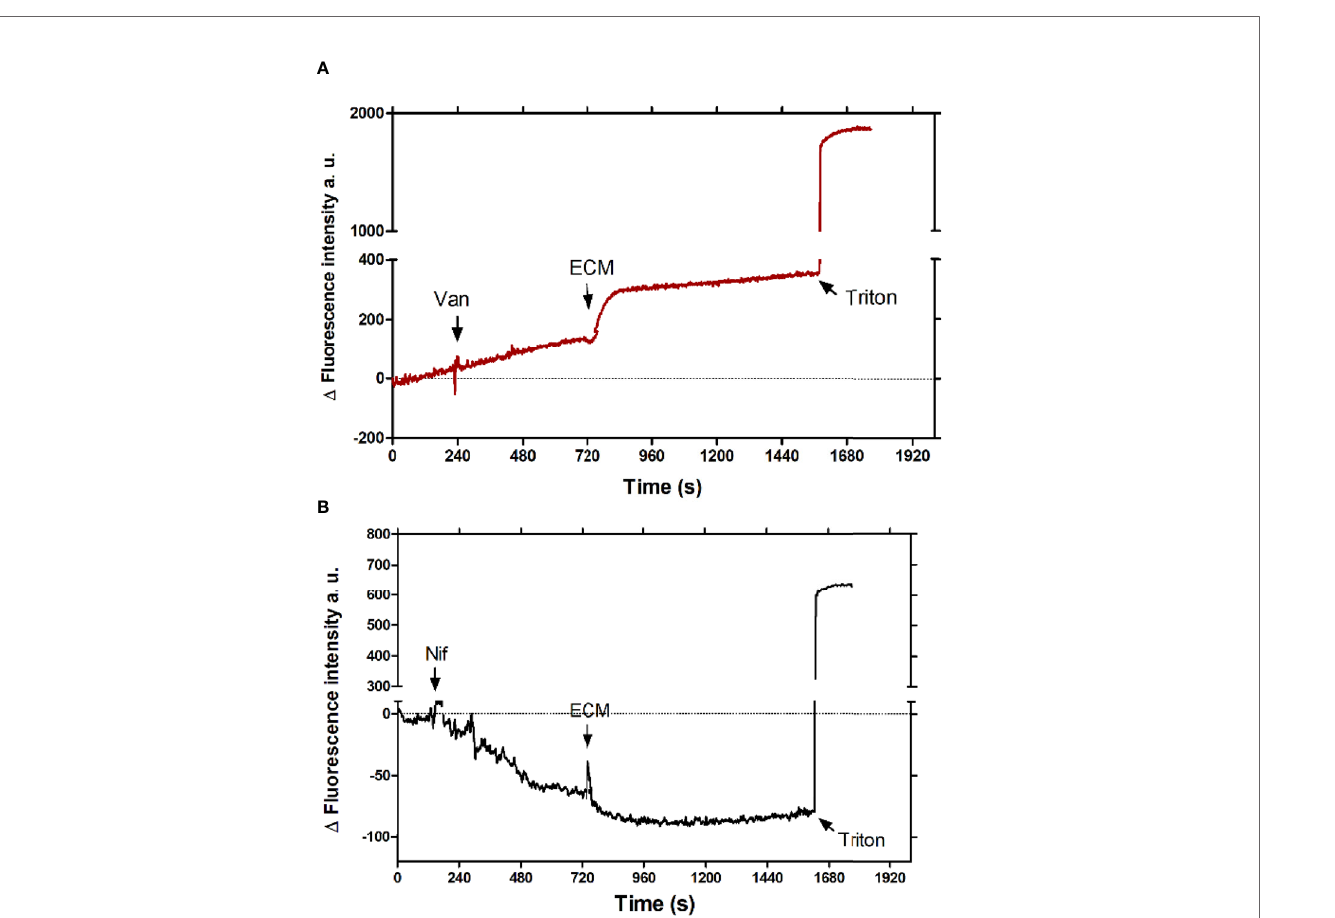
FIGURE 2 | Effect of Ca 2+ channel inhibitors in the intracellular Ca 2+ concentration of tissue culture-derived trypomastigotes upon interaction with the ECM. (A) 1 mM Vanadate (Van) (red line) or (B) 4 µM Nifedipine (Nif) (black line) were added to 5 x 10 7 Fluo-4-loaded trypomastigotes, followed by the addition of 24 µg of ECM after the signal stabilization. 0.03% Triton-X100 was added at the end of experiment to determine the maximum fl uorescence value. The graph is representative of three independent